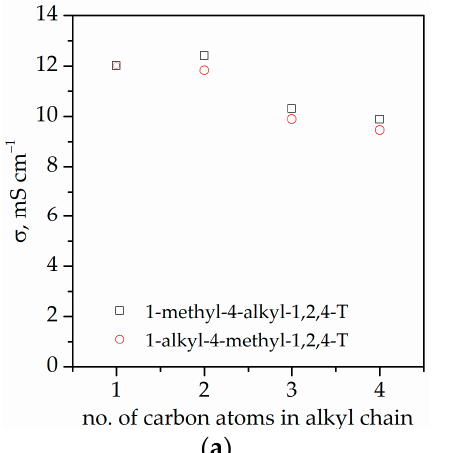
Gels 2022 , 8 , x FOR PEER REVIEW 21 of 25 Figure 8. ( a ) Ionic conductivity of the mixtures of ionic liquids with PC. ( b ) Relative conductivity of ionogels. Filled symbols—PETMP+TATT system; open symbols—PETMB+TATT system.